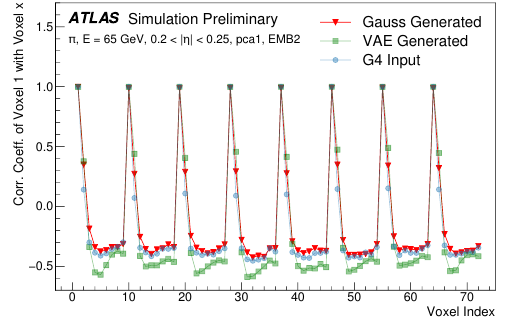
Figure 4. Correlation coe ffi cient of ratios of voxel energy in single events to the corresponding voxel energy in the average shape, examined between the core bin from α = 0 to 2 π/ 8 and each of the other voxels. The periodic structure represents the binning in α , and the increasing numbers in each of these periods correspond to increasing R , where the eight points with correlation coe ffi cient 1 are the eight core bins. Both the Gaussian and VAE generated toy events are able to reproduce the major correlation structures for 65 GeV central pions in EMB2 [7].